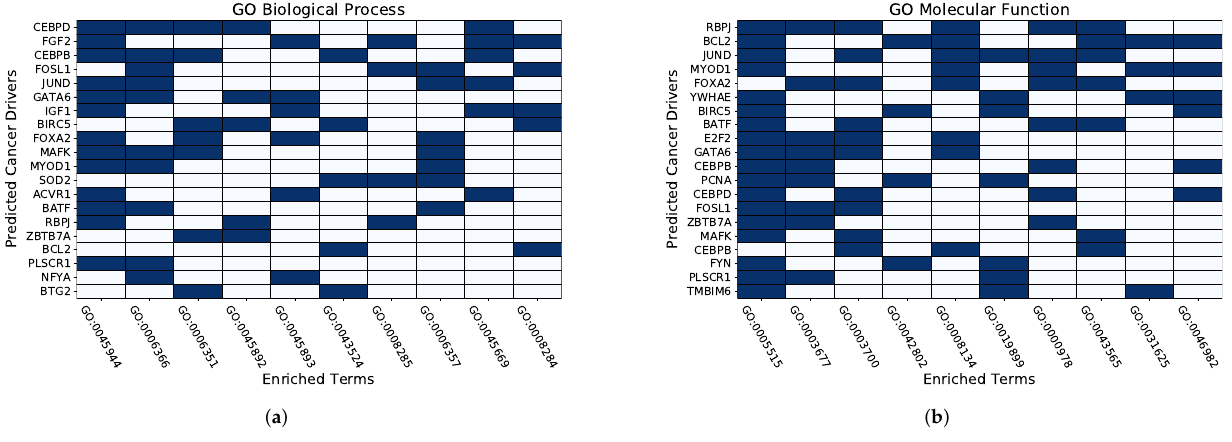
Figure 5. The heatmaps of ( a , b ) show enrichment profiles for GO biological processes and GO molecular functions,